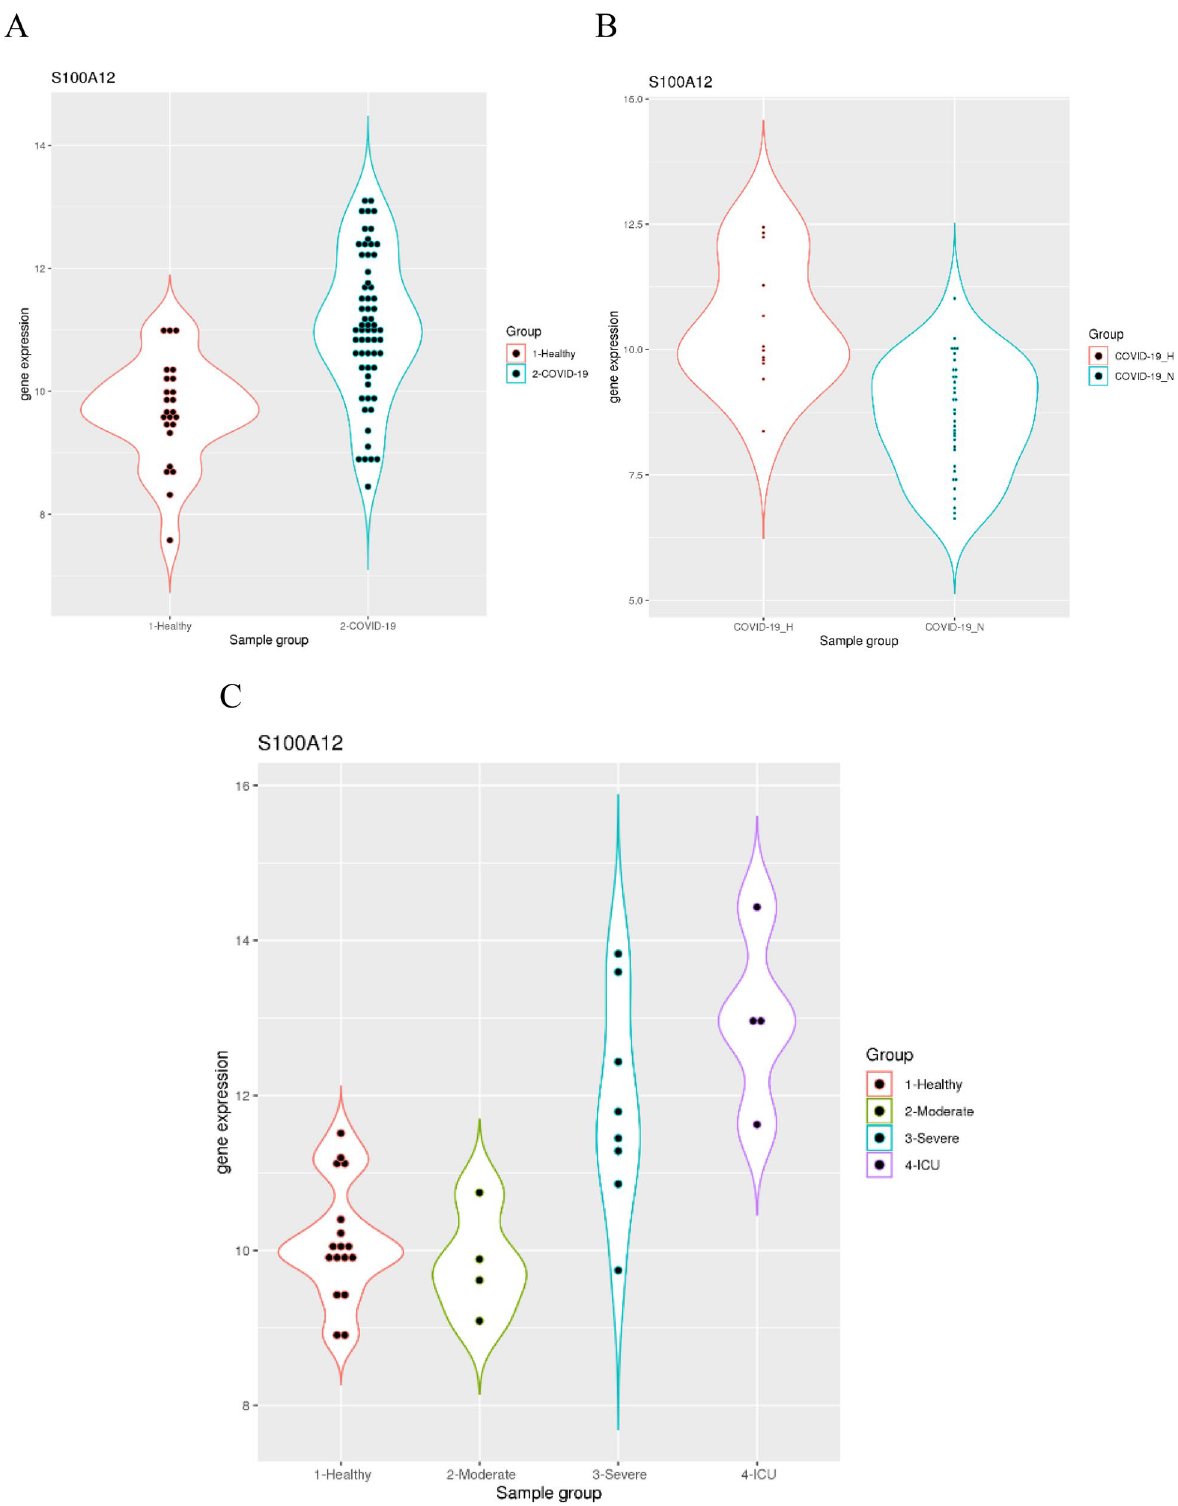
Figure 4. S100A12 expression elevated in severe and critical COVID-19 patients. ( A ) upper left, comparison of S100A12 expression in healthy controls and COVID-19 patients. ( B ) upper right, comparison of S100A12 expression in hospitalized and non-hospitalized COVID-19 patients. ( C ) lower panel, comparison of S100A12 expression in healthy controls and patients with COVID-19 at three severity levels (moderate, severe and